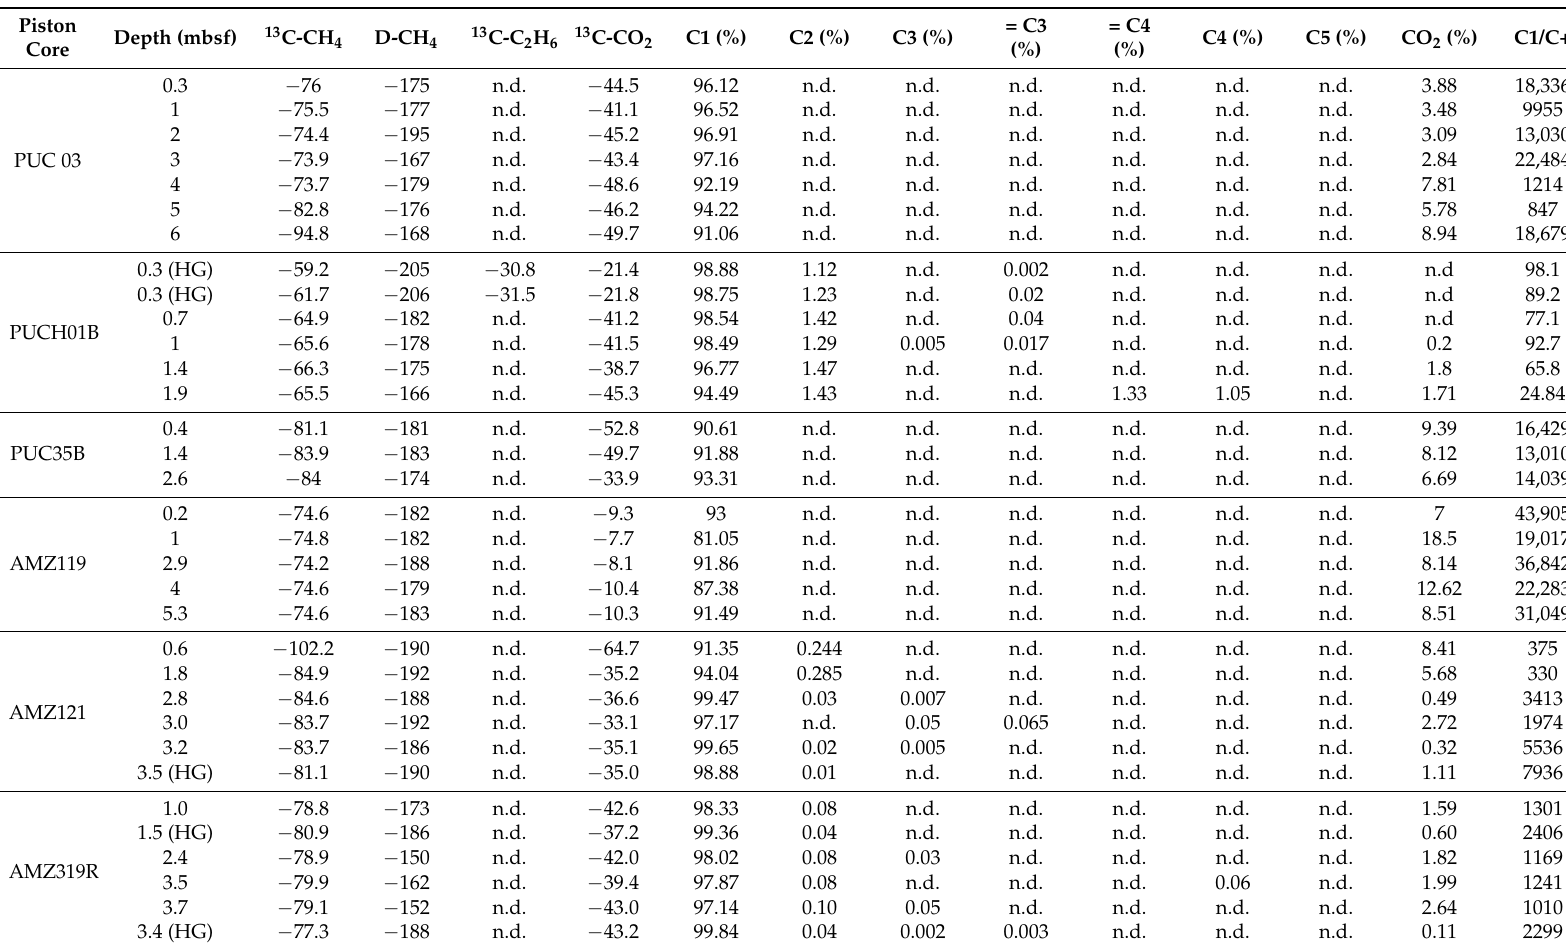
Table 1. Molecular and stable isotope compositions of hydrate-bound gases (HG) and headspace gases at all sites. Methane (C1), ethane (C2), propane (C3), propene (=C3), butene (=C4), butane (C4), pentane (C5). The depth is in meters below sea floor (mbsf).